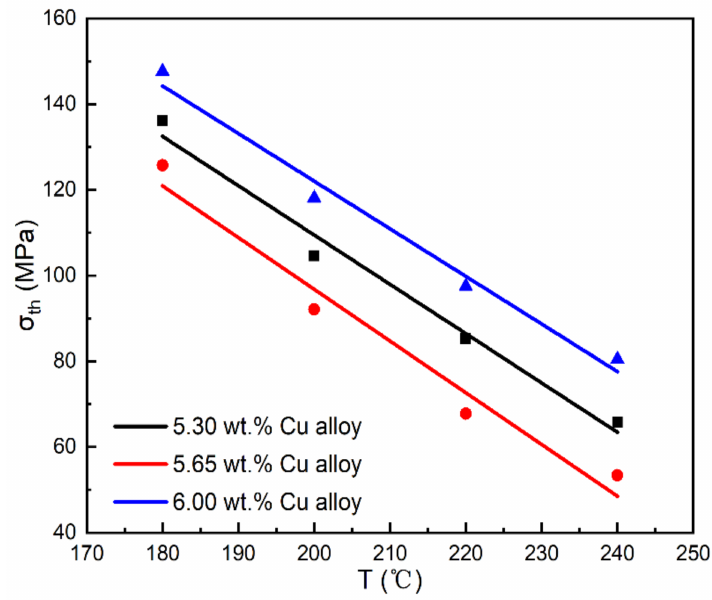
Figure 9. Plots of the threshold stress versus temperature of three Al–Cu–Mg–Ag